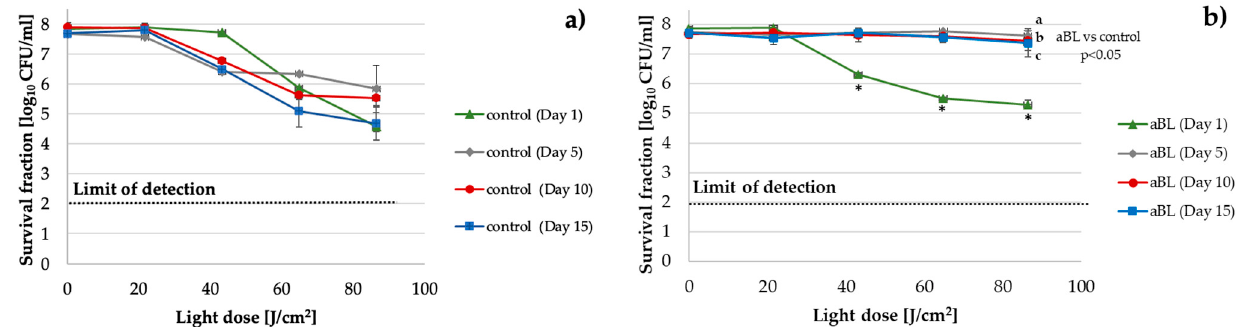
Figure 2. K. pneumoniae (ATCC700603) aBL tolerance development upon exposure to sublethal aBL treatment. Overnight K. pneumoniae cultures (37 °C in LB for 16–20 h) were diluted to an OD of 0.5 McF, and 100-µL samples were irradiated with 415 nm light at a dose of 61.2 J/cm 2 (MDK 99 ). Following exposure, 10-µL aliquots of the treated samples were collected to determine the survival rate. A total of 50-µL of the sample was transferred into fresh LB medium (5 mL) to regrow overnight. The next day, after 16–20 h of incubation, the treatment was repeated under the same conditions. The cycle of exposure—regrowth—exposure was repeated 15 times. The potential reductions in the susceptibility of K. pneumoniae to aBL were examined after the 5th, 10th, and 15th consecutive cycles at higher doses of light (up to 86.4 J/cm 2 ) ( a ). The efficacy of aBL was also tested in samples from untreated controls (passaged daily without the selective pressure of aBL) ( b ). The detection limit was 100 CFU/mL. The values are the means of three separate experiments. The error bars represent the standard deviations (SDs). a —aBL (Day 5) vs. control (Day 5), b —aBL (Day 10) vs. control (Day 10), c —aBL (Day 15) vs. control (Day 15)—significant results indicated for light doses ranging from 43.2 J/cm 2 to 86.4 J/cm 2 . * All of the significant differences were estimated in comparison to the control from each day.